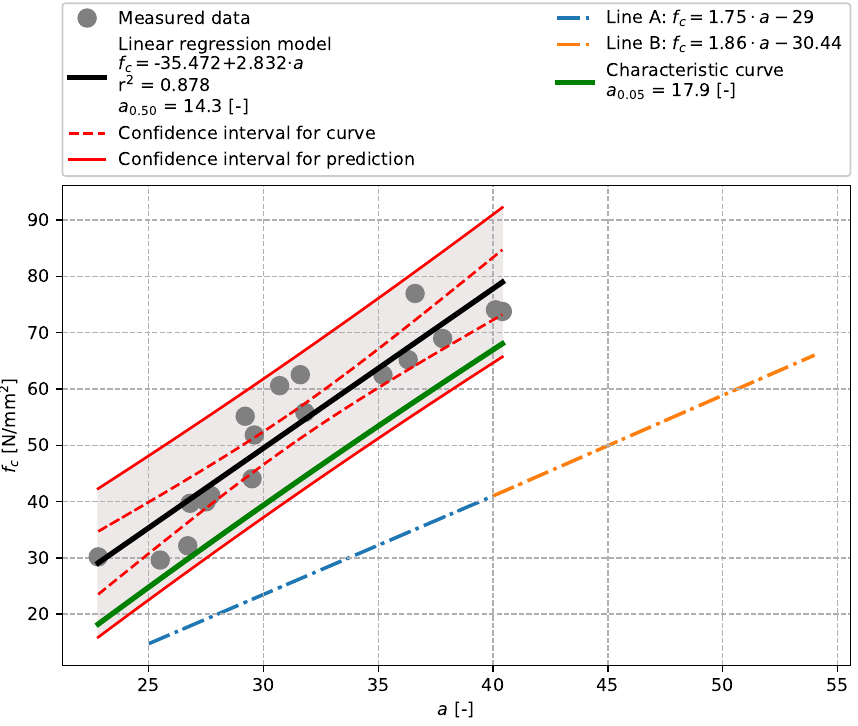
Figure 5. Bridge concrete described in Section 3.1—model of the dependence of the rebound number [-] vs. compressive strength f c [N/mm 2 ]—Original Schmidt N.